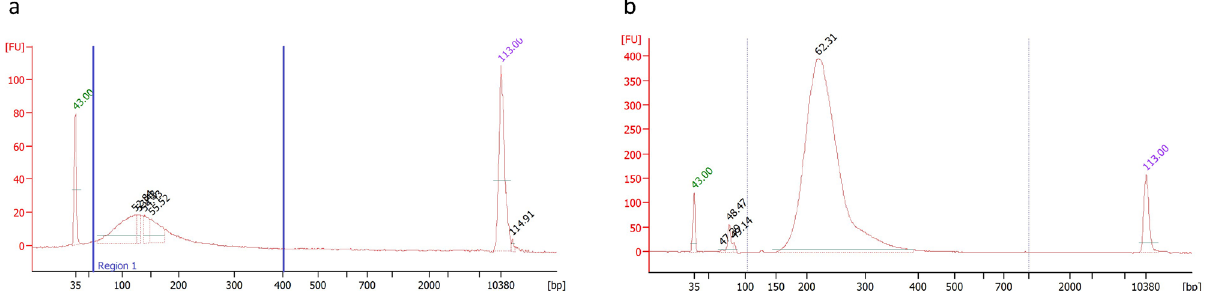
Figure 2. DNA size profile measured using a High Sensitivity DNA chip on an Agilent Bioanalyzer. ( a ) Isolated DNA from RMSF vaccine; ( b ) Final Illumina sequencing library with adaptor-ligated made from DNA isolated from RMSF vaccine. y-axis of the electropherograms represents fluorescent units (FU) and the x-axis represents the nucleotide length in base pair